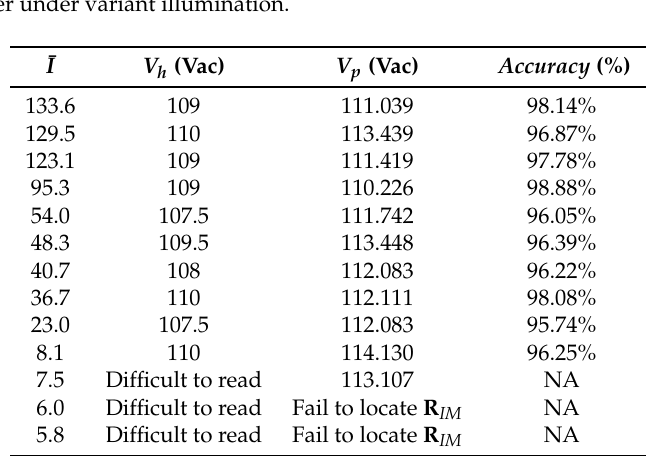
Table 9. Results of reading the A-meter YF-370A with 15.425 ◦ rotation for the measurement of the 110 Vac line power under variant illumination.